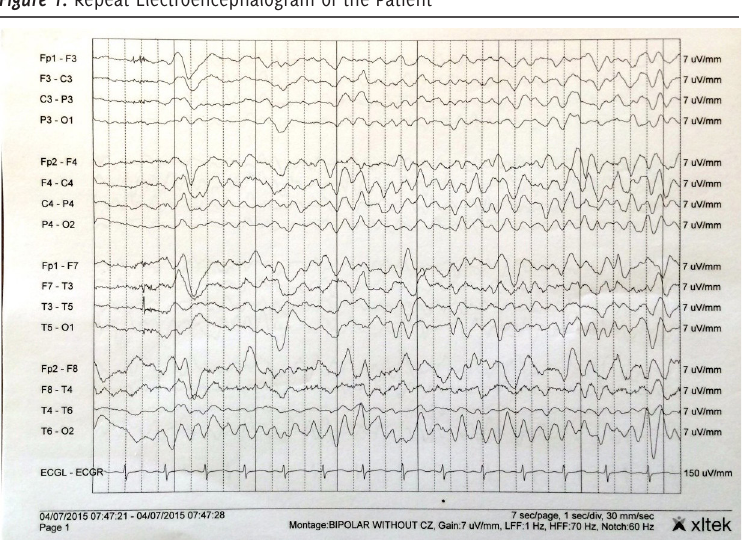
Electroencephalogram (EEG) of the patient displaying frequent triphasic spike and wave complexes. Dis- charges were frequent and at times continuous, lasting for hours. EEG was reviewed in a double banana montage with sensitivity at 7 microvolts and a time base of 30 mm/s. Background activity was seen primarily at 4–5 Hz. Figure 2. Brain Magnetic Resonance Imaging (MRI) of the Patient